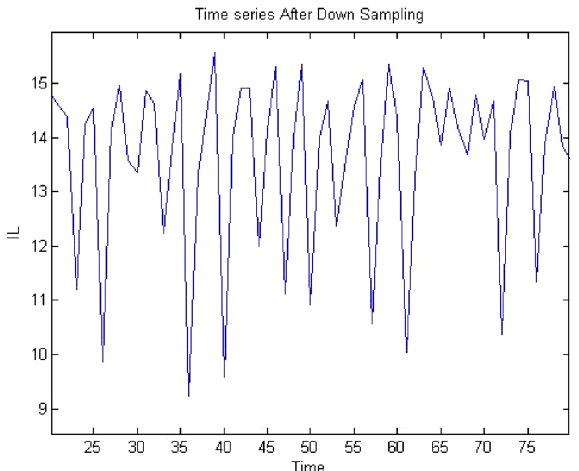
Figure 35. Time series of forward converter at chaotic after down sampling.